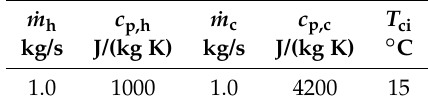
Table 1. Assumptions for parametric thermodynamic optimisation